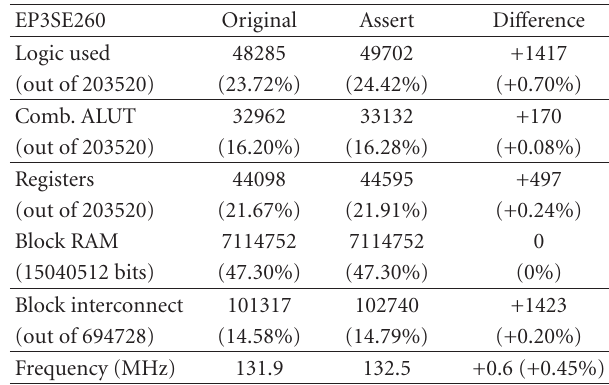
Table 5: Individual backprojection timing assertion overhead.